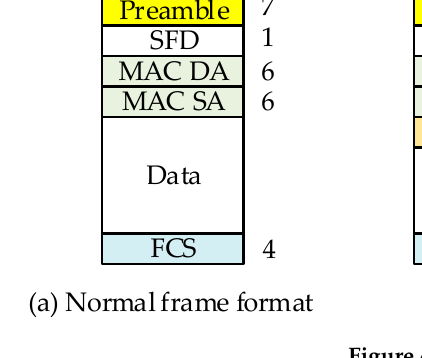
Figure 4 . IEEE 802.1Qbu frame format. Figure 4. IEEE 802.1Qbu frame format. Table 2. Fragmented frame